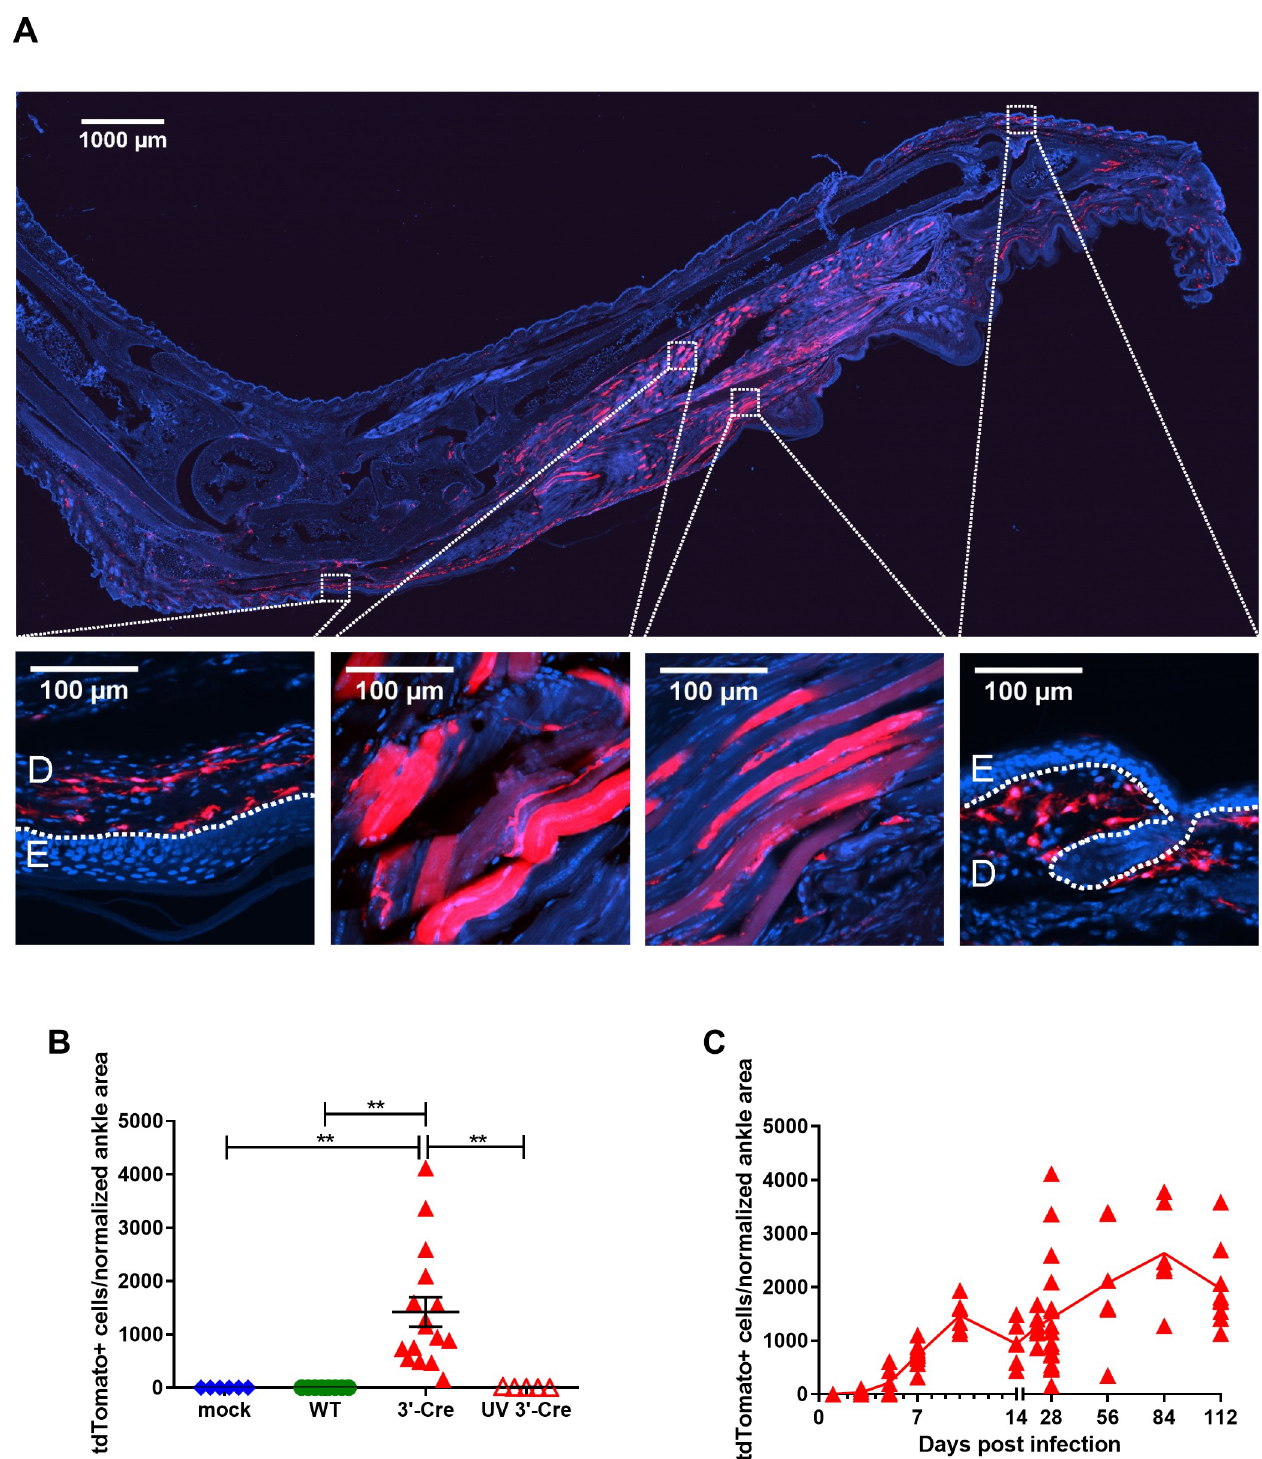
Fig 4. Cells are marked by CHIKV-3´-Cre at time points in the chronic phase. tdTomato mice were mock-infected (mock, blue circles) or inoculated with 10 6 PFU CHIKV-WT (WT, green circles), CHIKV-3´-Cre (3´-Cre, red triangles), or UV-inactivated CHIKV-3´-Cre (UV 3´-Cre, open red triangles), and ipsilateral feet and ankles were processed at 28 dpi. (A) Representative image of frozen sections of whole ankle and foot 28 dpi with CHIKV-3´-Cre. Blue shows DAPI staining, and red is tdTomato; scale bar represents 1000 μ m. Higher magnification inset images of skin and muscle from mice infected with CHIKV-3´-Cre. Scale bars represent 100 μ m; the skin is divided into dermis (D) and epidermis (E). (B) The total number of tdTomato + cells was quantified at